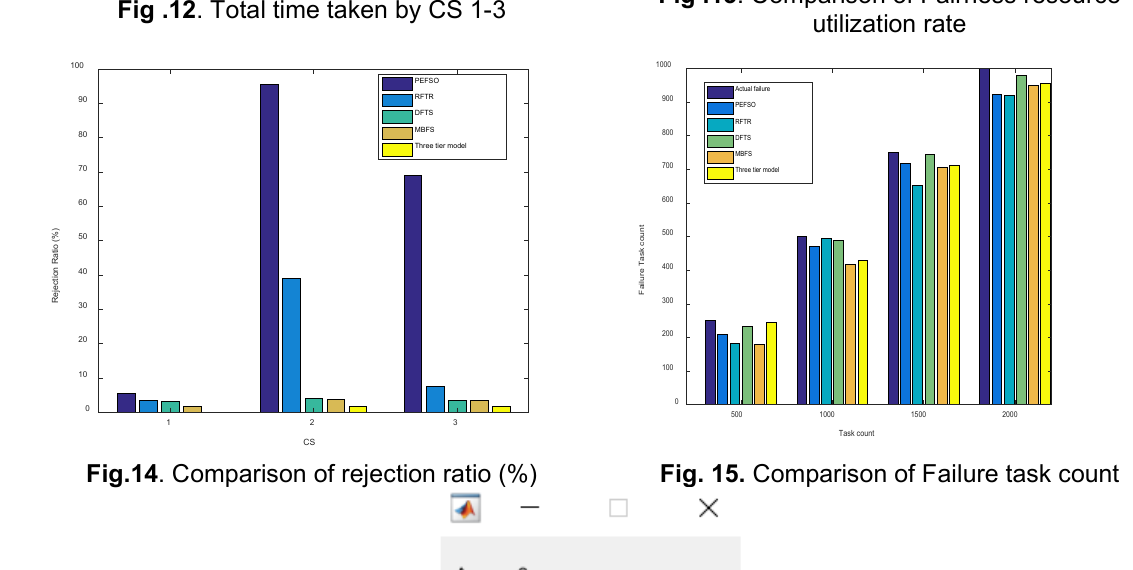
Fig .13 . Comparison of Fairness resource